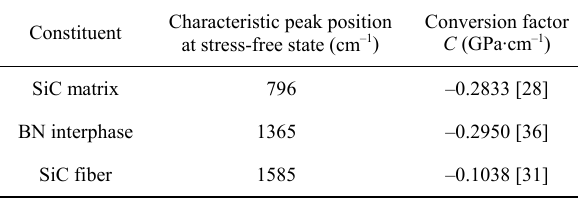
Table 1 Characteristic peak positions at stress-free states and conversion factors of peak shift to